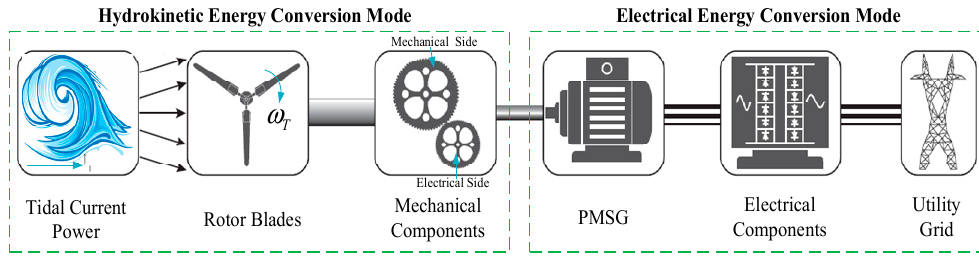
Figure 1. Block diagram of tidal energy conversion system.